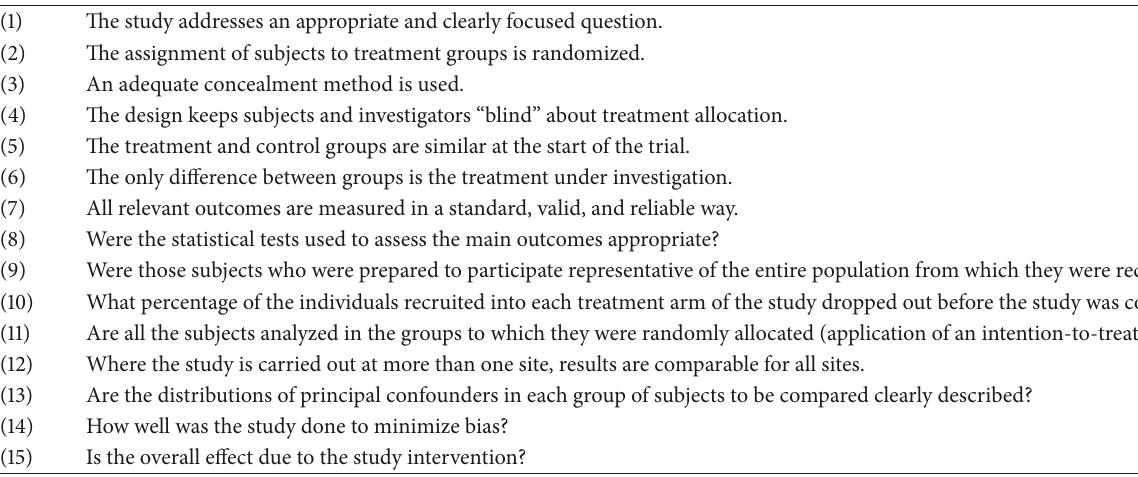
Table 1: Adapted SIGN